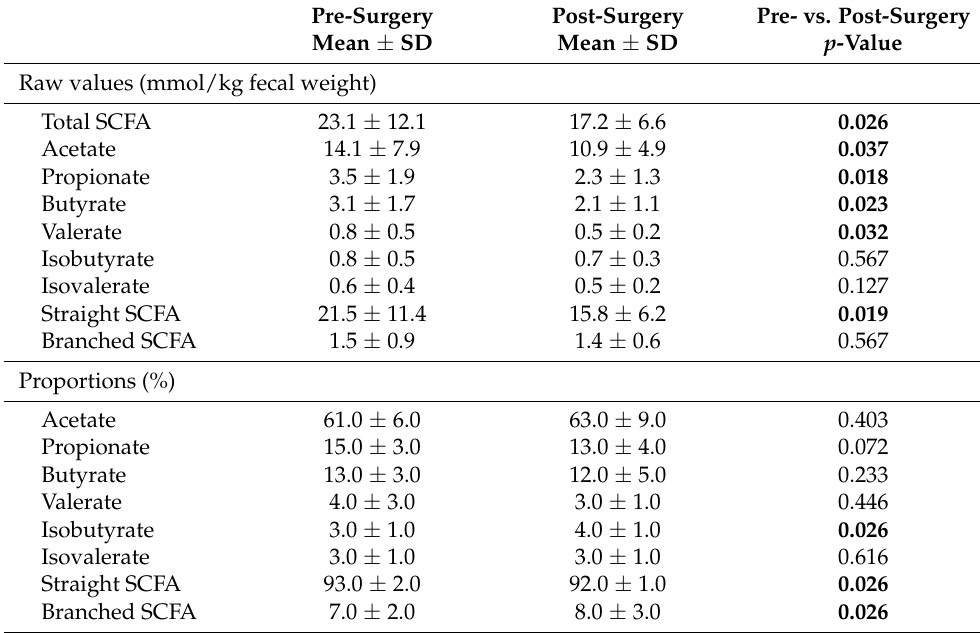
Table 2. Short-chain fatty acid response to bariatric surgery in all participants. Significance denoted with unadjusted p -value < 0.05 (bolded). Represents paired t -test. Pre-Surgery Post-Surgery Pre- vs. Post-Surgery p